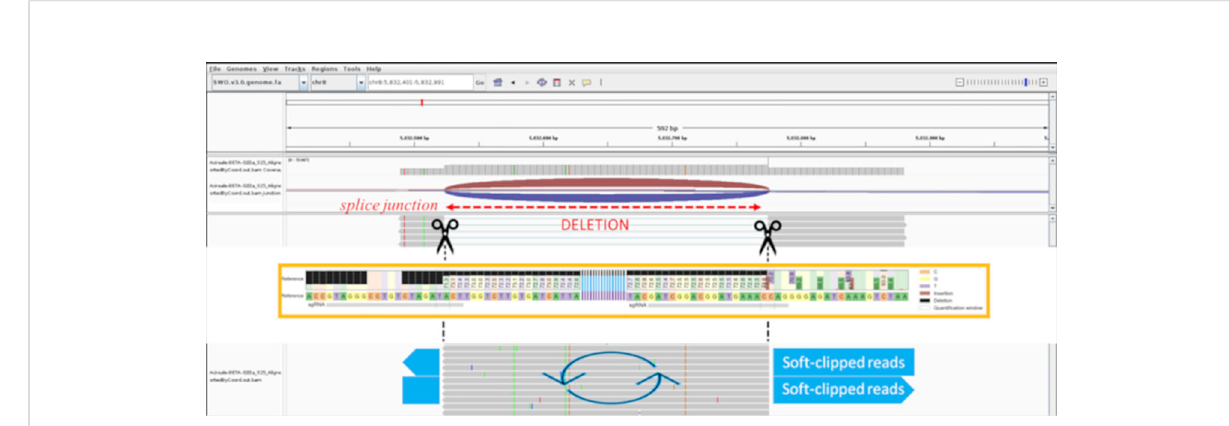
FIGURE 3 IGV screenshot of the 32Da sample realigned by STAR. The scissors represent the cleavage sites of Cas9, the splice junction shows the deletion (indicated in red), light blue large arrows show the soft-clipped portion of the inverted reads. The orange box refers tois the CRISPResso2 output (not to scale with IGV) of the 32Da with a 30% minimum alignment score; the fragments external to the cleavage sites result in a mutated pro fi le with deletions on the left, and insertions and SNPs on the right (as reported in the